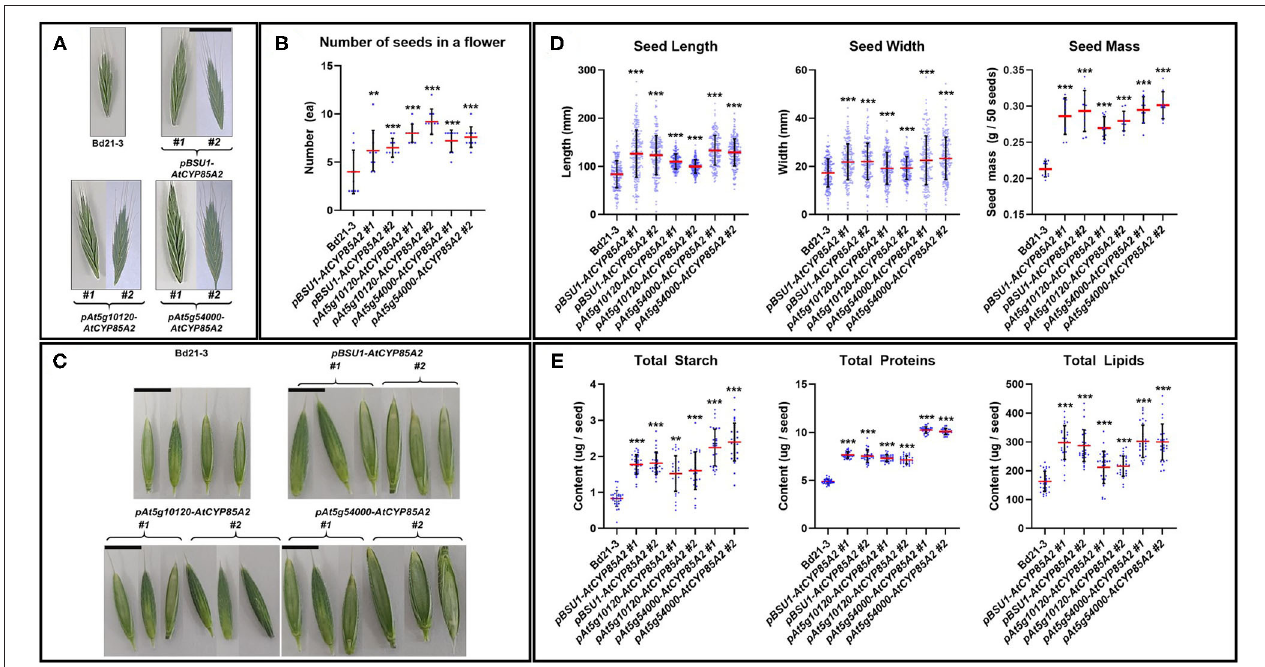
FIGURE 7 | Alterations of phenotype and contents of primary metabolites in seeds of transgenic Brachypodium. (A) Size of flower in wild type and transgenic Brachypodium. The scale bar in (A) indicates 1cm. (B) Number of seeds in a flower in wild type and transgenic Brachypodium. (C) Shape of seeds in wild type and transgenic Brachypodium. The scale bar in (C) indicates 50mm. (D) Size and mass of seeds in wild type and transgenic Brachypodium. (E) Total starch, proteins, and lipids content of seeds in wild type and transgenic Brachypodium. #1 and #2 represent two different lines for three transgenic plants. Each dot in (B,D,E) indicates individual data. Red and black line represents the mean of the individual measurements and the standard deviation (S.D.), respectively. Asterisks indicate the statistical significance of the Student’s t -test: ** ( P < 0.01) and *** ( P <